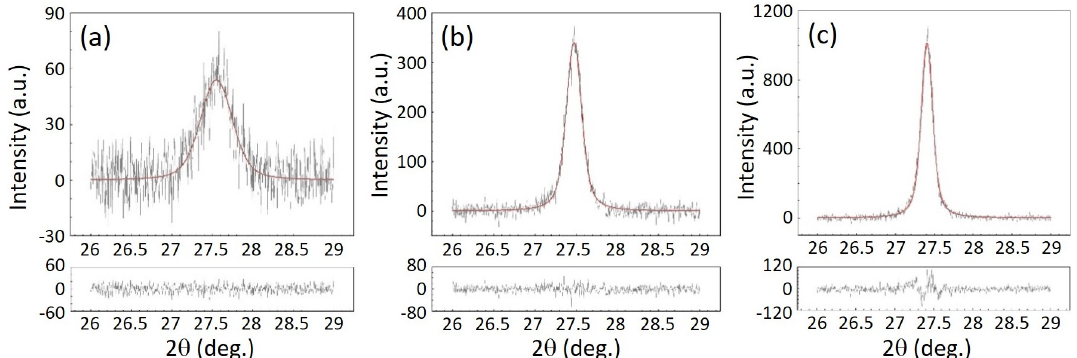
Figure 2. XRD profiles recorded for (111) peak in Bragg–Brentano theta–theta geometry for samples: ( a ) ZnSe2, ( b ) ZnSe3, and ( c ) ZnSe4. Table 1. Structural parameters of the ZnSe thin films deposited by RF magnetron sputtering at an